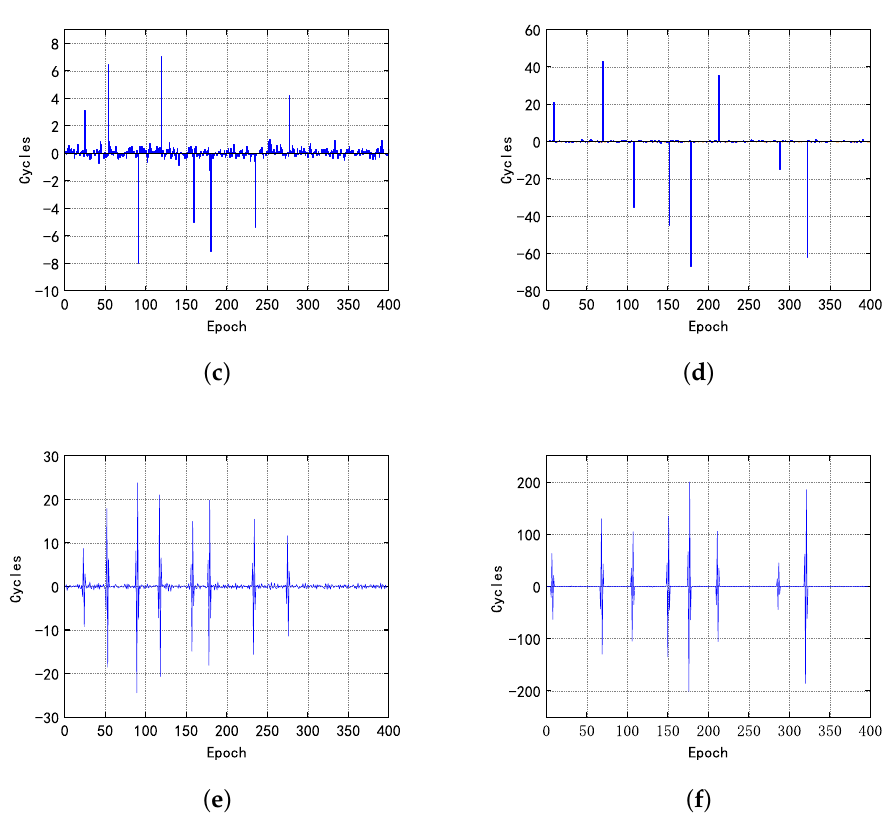
Figure 11. In the second case, the three columns on the left, the results obtained by three different methods ( a ) proposed indoor dual-frequency cycle slip detection method; ( b ) the proposed indoor dual-frequency cycle slip detection method; ( c ) Doppler method; ( d ) Doppler method; ( e ) high-order difference method in the third case, the three columns on the right,the results obtained by three different methods; ( f ) high-order difference method.